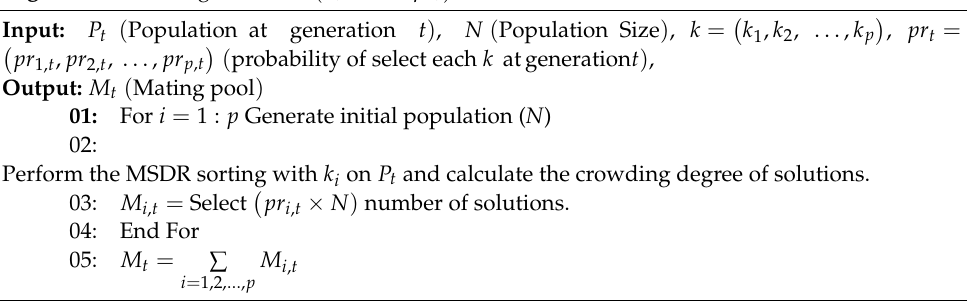
Algorithm 2: Mating_selection ( P t , N , k , pr t